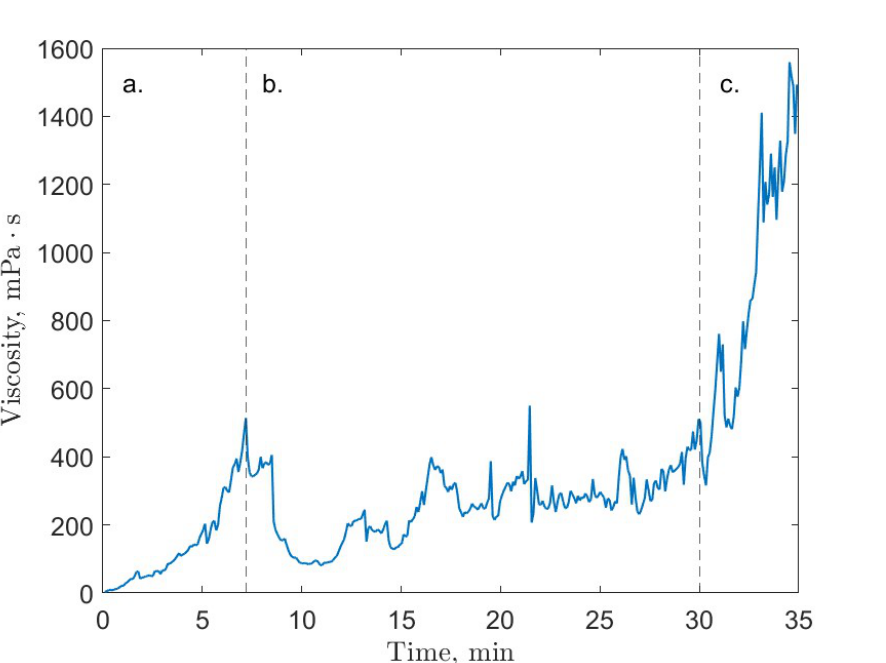
Figure 4. An example of the three stages of gas hydrate growth as characterized by the system’s viscosity; carbon dioxide test run at 2 °C and 30 MPag; ( a ) initial growth, ( b ) slurry stage, ( c ) final growth; figure adapted from Guerra et al.